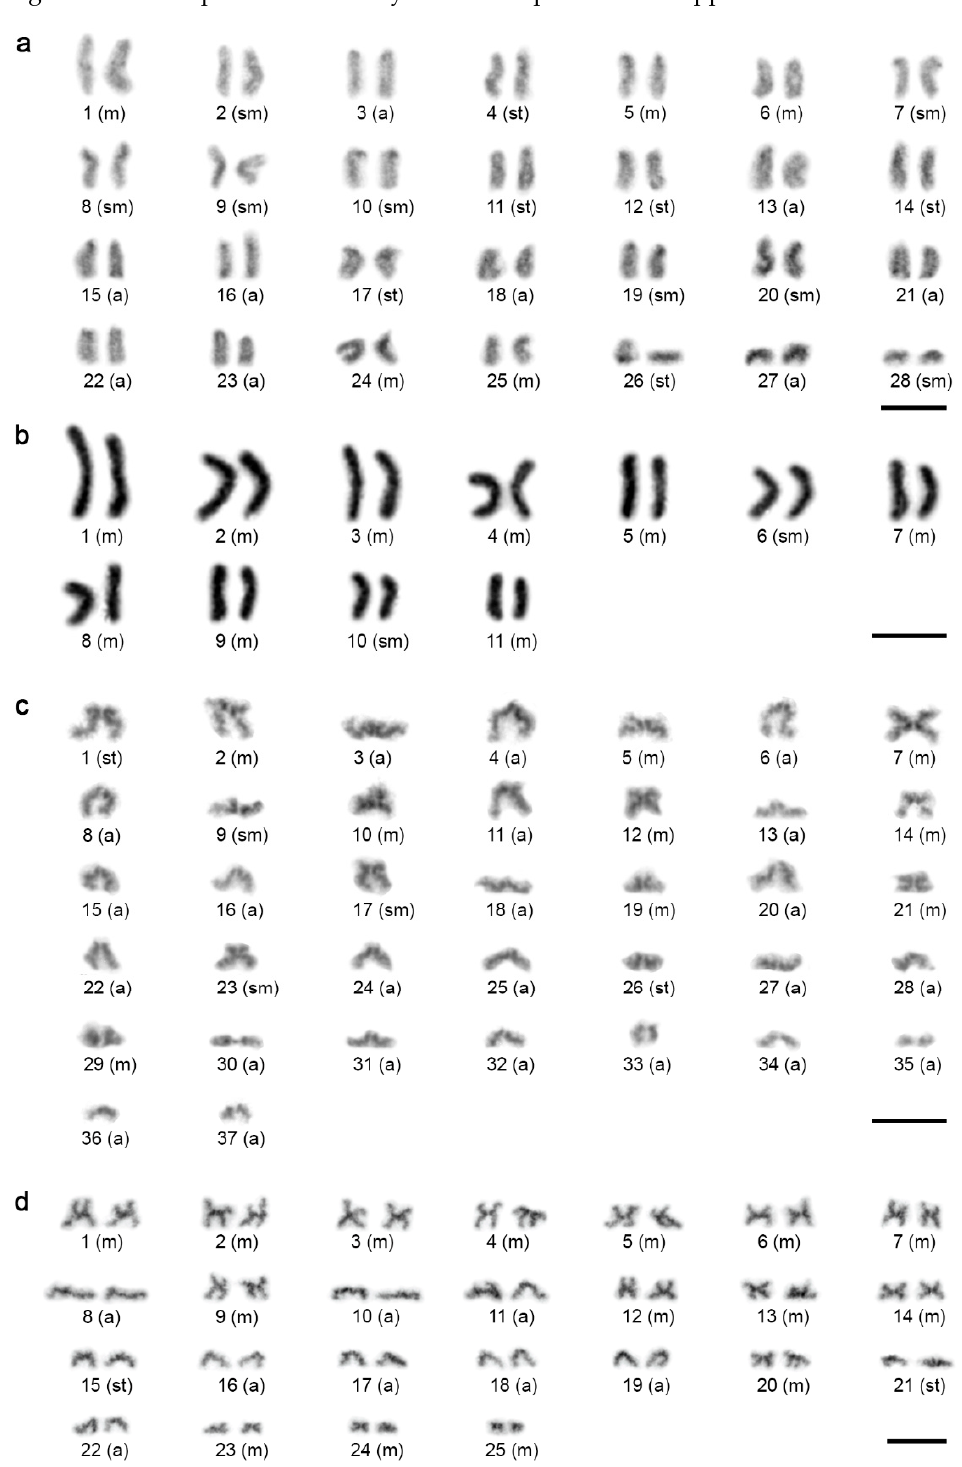
Figure 3. Male and female karyotypes of Sarax species, Giemsa-stained. Karyotypes were constructed from mitotic metaphase ( a , b ), metaphase II ( c ), or two sister metaphases II ( d ). ( a ) S . aff. batuensis , male (2 n = 56). ( b ) S. seychellarum , female (2 n = 22). ( c ) Sarax sp., male ( n = 37), haploid karyotype. ( d ) S. huberi , male (2 n = 50). Abbreviations: m = metacentric chromosome, sm = submetacentric chromosome, st = subtelocentric chromosome, a = acrocentric chromosome. Scale bar = 10 μ m.